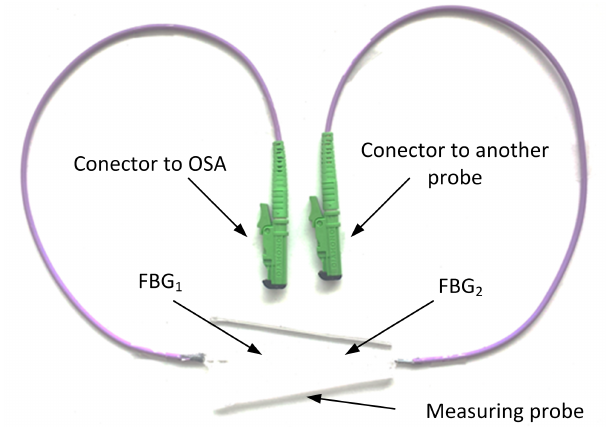
Figure 3. The designed and realized probe.